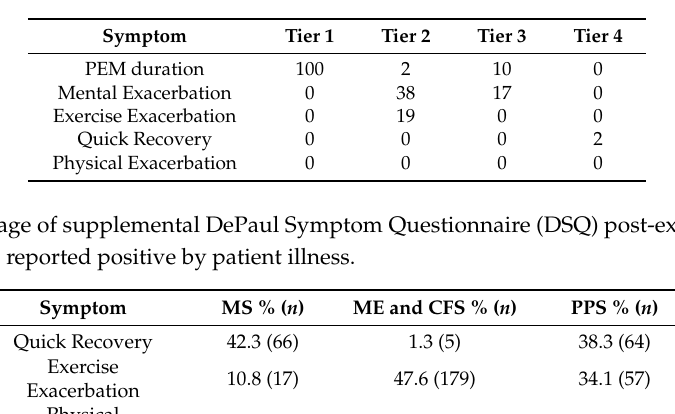
Table 1. Number of times all symptoms appeared in decision trees.